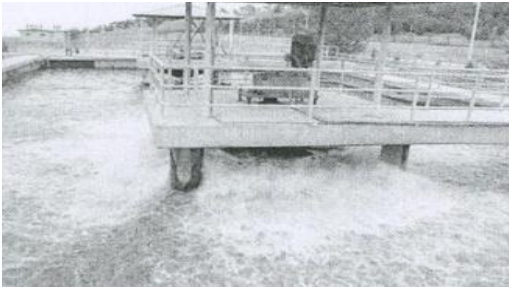
Fig. 9. Surface aerators cause lower BOD removal